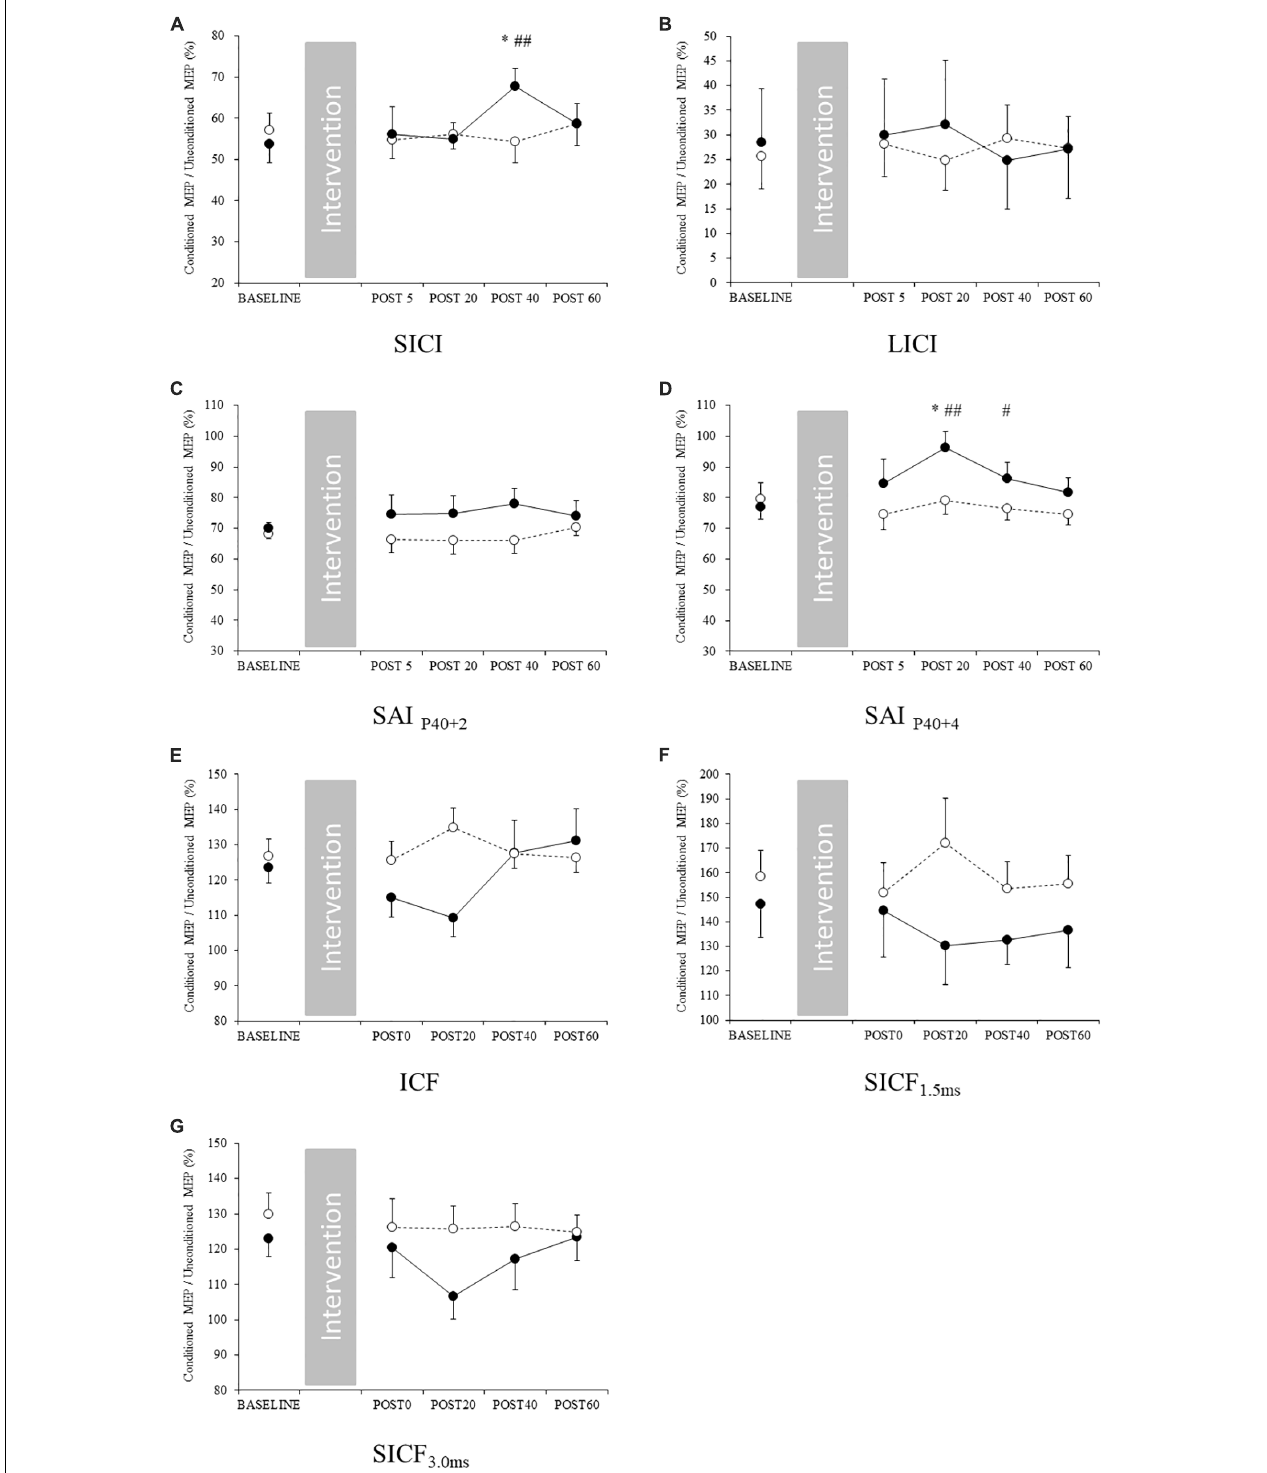
FIGURE 3 | Changes in intracortical circuits in the M1 exercised area. Filled and open circles indicate exercise and control conditions, respectively. (A) Short-interval intracortical inhibition, (B) long-interval intracortical inhibition, (C) short-latency afferent inhibition P 40 + 2 and (D) short-latency afferent inhibition P 40 + 4 , (E) intracortical facilitation, (F) short-interval intracortical facilitation 1.5 ms, and (G) short-interval intracortical facilitation 3 ms. ∗ p < 0.05 compared with baseline, # p < 0.05 compared with control condition. ## p < 0.01 compared with control condition.